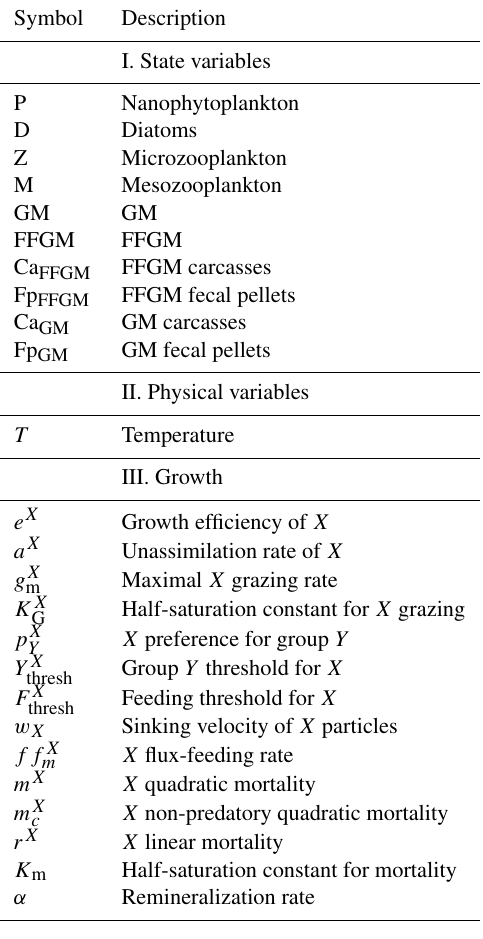
Table 1. Variables and parameters used in the set of equations gov- erning the temporal evolution of the state